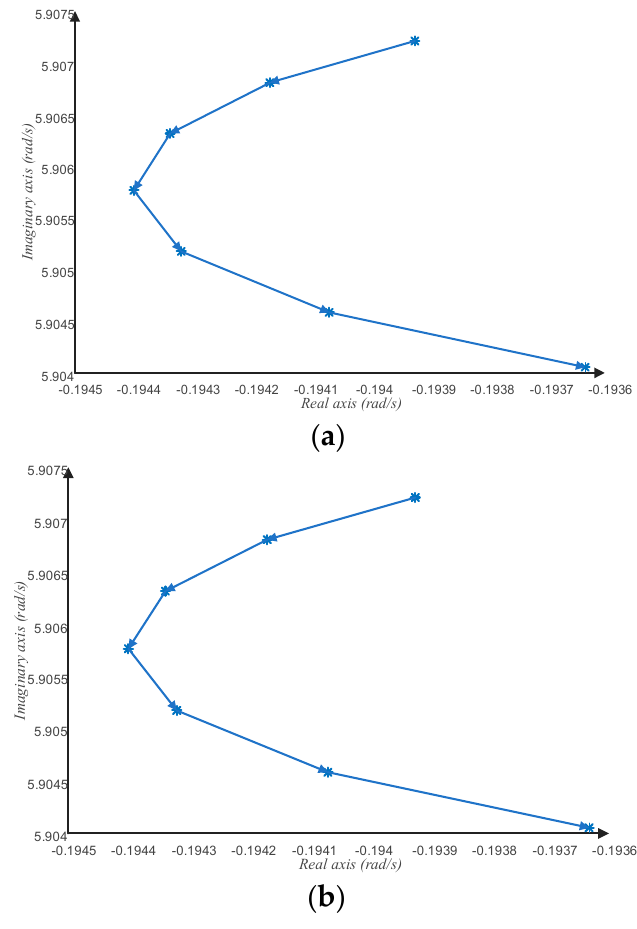
Figure 9. Modal trajectory regulated by time-delay: ( a ) 0 s to 0.24 s, ( b ) 0.28 s to 0.4 s.